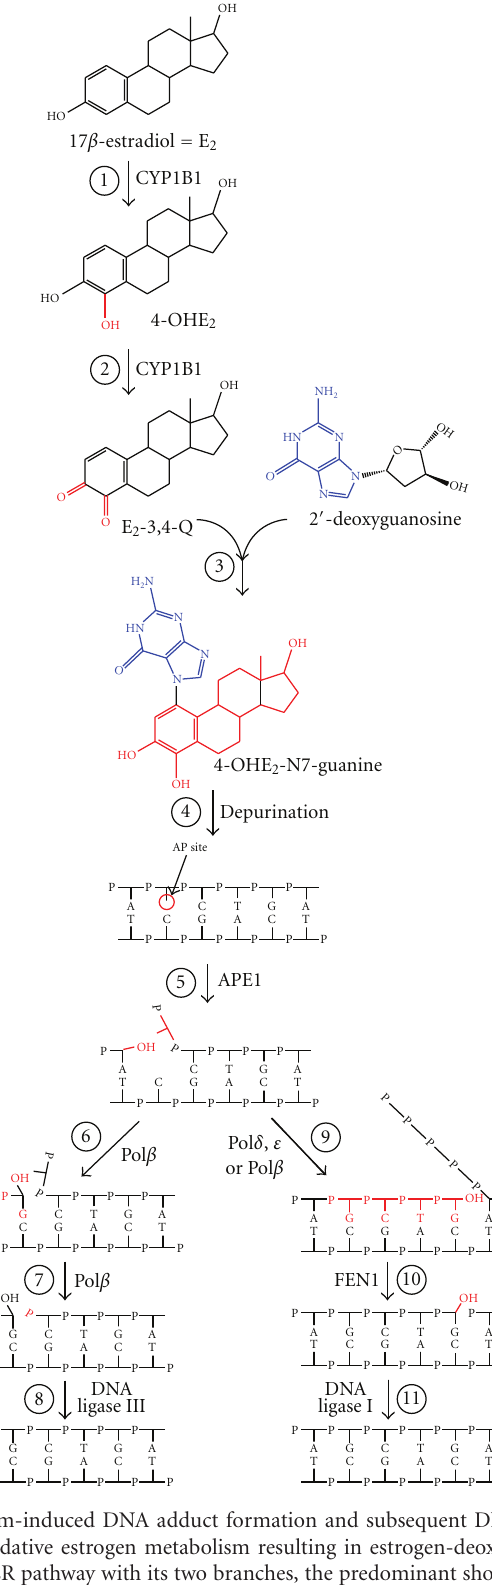
Figure 1: Overview of estrogen metabolism-induced DNA adduct formation and subsequent DNA repair by BER. The top sequence of reactions shows the CYP1B1-mediated oxidative estrogen metabolism resulting in estrogen-deoxyribonucleoside adduct formation. The bottom sequence of reactions shows the BER pathway with its two branches, the predominant short-patch pathway (left) and the alternate long-patch pathway (right). Not shown is the formation of the catechol estrogen 2-OHE 2 , which yields stable adducts, and the redox cycling of catechol estrogens and estrogen quinones, which generates reactive oxygen species capable of producing oxidative DNA